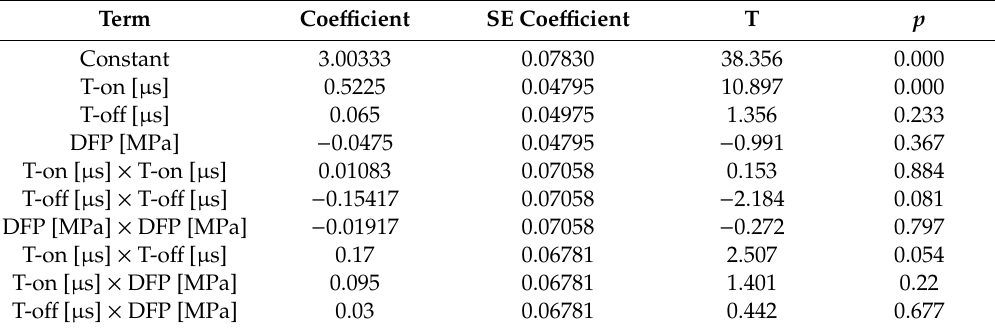
Table 9. Estimated regression coe ffi cients and summary statistics of adopted response surface full quadratic model for Ra.